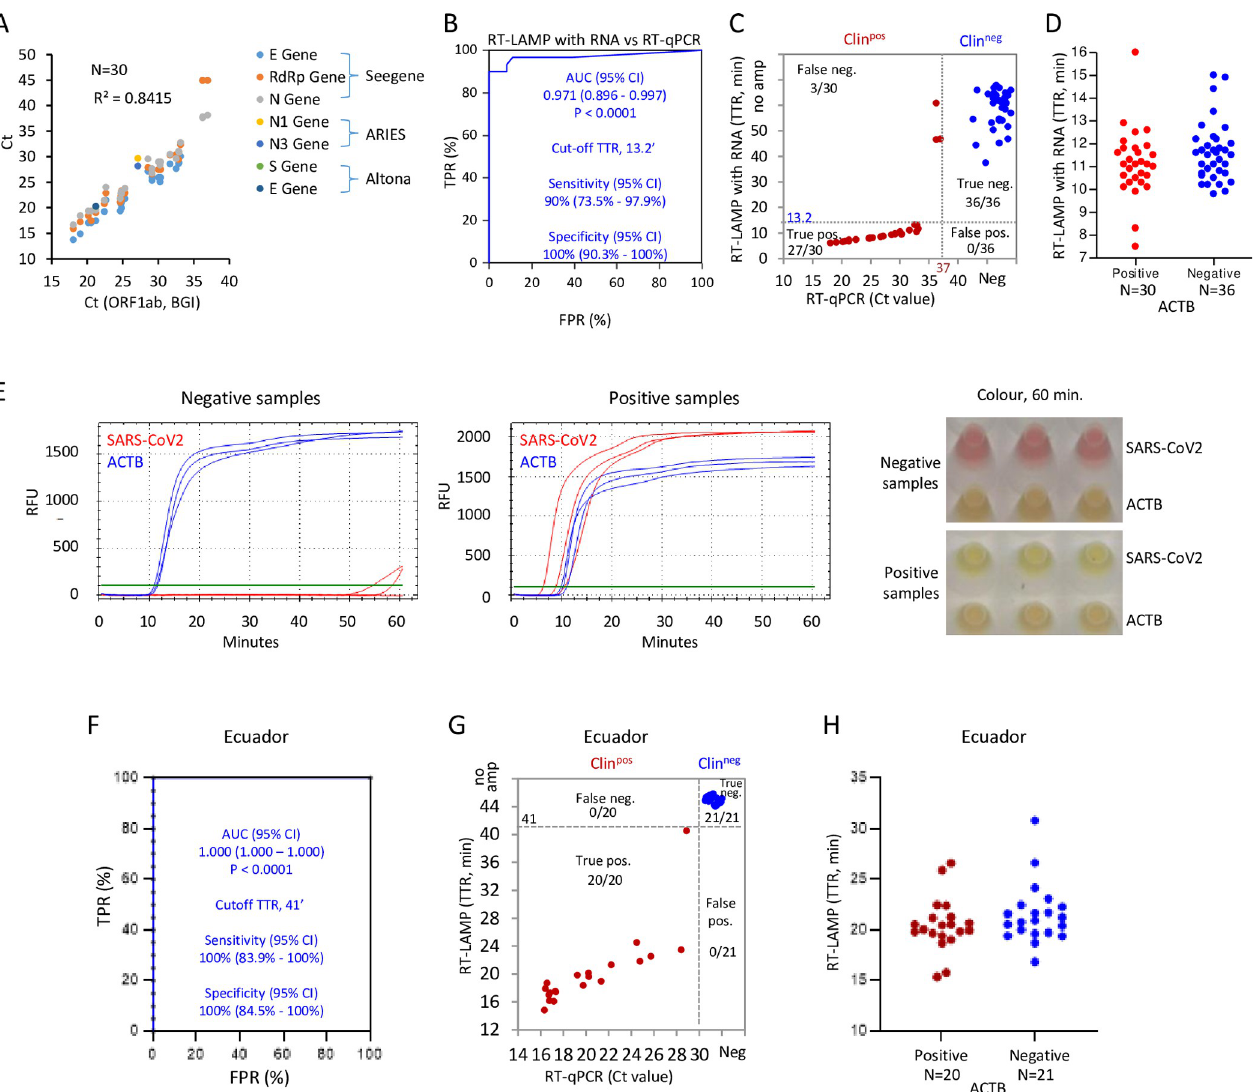
Fig 4. Comparison of RT-LAMP and BGI RT-PCR with extracted RNA from clinical NP samples. (A) Correlation of Ct values with BGI RT-PCR kit vs . other indicated RT-PCR reagents in 30 SARS-CoV-2 positive clinical NP samples. (B) ROC curve evaluating RT-LAMP performance with 30 positive and 36 negative Canadian clinical samples based on the results of BGI RT-PCR kit. TPR: True positive rate; FPR: False positive rate. TTR � 13.2’ was defined as the cut-off to distinguish positive from negative samples with 90% detection sensitivity and 100% specificity. (C) Distribution of RT-LAMP TTRs against BGI RT-PCR Ct values for 30 positive and 36 negative clinical NP samples. BGI RT-PCR and RT-LAMP positives were defined by Ct < 37.0 and TTR � 13.2’ respectively. (D) Distribution of human ACTB TTRs. (E) Representative fluorescent readouts and phenol red colour with RT-LAMP reactions at 60 minutes in (C and D) with the clinical NP samples. (F) ROC curve evaluating RT-LAMP performance with 21 positive and 21 negative NP samples from Ecuador. TTR � 41’ was defined as the cut-off to distinguish positive from negative samples with 100% specificity and sensitivity. (G) Distribution of RT-LAMP TTRs vs . RT-PCR Ct values for gene E with samples in (F). RT-PCR and RT-LAMP positives were defined by Ct � 30.0 for gene E and TTR � 41’ respectively. (H) Distribution of human ACTB TTRs of samples in